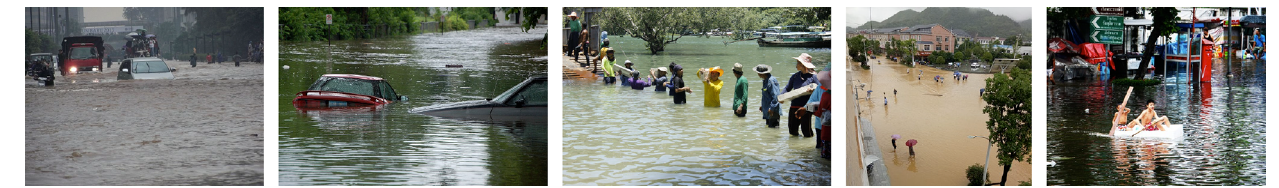
Figure 3. Public-domain images of flooding, representative of the dataset provided by Chaudhary (2018) that was used in this work. Table 1. Training strategies for the deep convolutional neural network. Strategy Images used for training Data augmentation steps Training steps Random displacement of up to Basic 1214 images from Internet 20%, random horizontal flip (Chaudhary, 2018) + 300 images from Cityscapes (Cordts et al., 2015) Augmented Same as Basic Same as Basic + random Gaussian blur, color desaturation, contrast modification, brightness alteration, reduction of resolution Fine-tuned Same as Basic No augmentation is applied when + seven frames taken from each fine-tuning the network. video